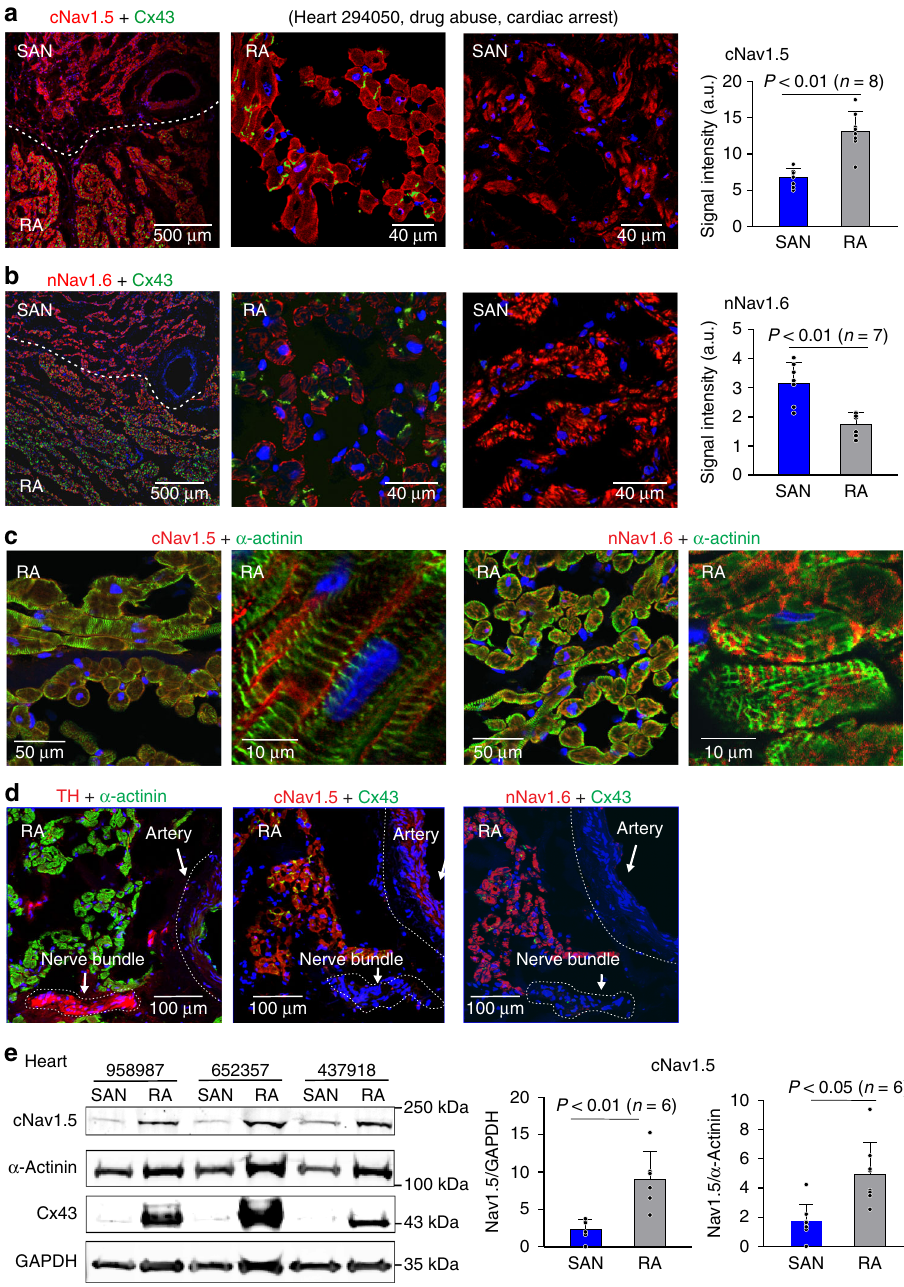
Fig. 6 Protein distribution of cNav1.5 and nNav1.6 in the human SAN and RA. a Left to right: immuno fl uorescence image showing double staining of cNav1.5 (red) and Cx43 (green) in human heart 294050 cryosection with sinoatrial node (SAN) and right atrial (RA) regions ( n = 8) separated by white dotted line; magni fi cation of image to show the distribution of cNav1.5 in the RA vs. the SAN; bar graph showing fl uorescence signal intensity in the human SAN vs. RA. b Left to right: immuno fl uorescence image showing double staining of nNav1.6 (red) and Cx43 (green) in human heart cryosection with SAN and RA regions ( n = 7) separated by white dotted line; magni fi cation of image to show the distribution of Nav1.6 in the RA vs. the SAN; bar graph showing fl uorescence signal intensity in the human SAN vs. RA. c Left to right: cNav1.5 (red) and α -actinin (green; staining cardiomyocytes) dual staining; nNav1.6 (red) and α -actinin (green) dual staining con fi rm the cardiomyocyte-speci fi c localization of cNav1.5 and nNav1.6. d Serial sections staining cNav1.5, nNav1.6, Cx43, and a nerve bundle labeled by anti-tyrosine hydroxylase (TH: staining sympathetic nerves) show that nNav1.6 and cNav1.5 are predominantly found in the myocytes relative to nerve bundles. All presented images a – d were collected from human heart 294050. e Left: representative immunoblotting bands for cNav1.5, α -actinin (marker of cardiomyocytes), and Cx43. Right: summary data of immunoblotting results of cNav1.5 protein distribution in the human SAN ( n = 6) and RA ( n = 6), compared with GAPDH (middle) and α -actinin (right), respectively. Cx43 connexin-43, GAPDH glyceraldehyde 3-phosphate dehydrogenase. Data were represented in mean ± SD. For immunostaining, analysis was done using lme4 and emmeans packages in R 3.4.4. Predictors included Heart (treated as random effect) and Condition ( fi xed effect). Pairwise tests between Condition levels were adjusted using Tukey ’ s method. Western blotting data analysis was done using two-sided t -test. Source data and uncropped versions of the western blot are provided as a Source Data fi